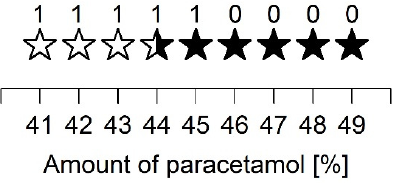
Figure 2. Stability of ASDs prepared with PVP/VA during storage (storage conditions: 23 °C/75% RH and 40 °C/75% RH; no differences were observed between the two storage conditions). Stars represent three types of recrystallization. Open stars show recrystallization in polymorphic form I. Closed stars show recrystallization in polymorphic form II. Semiclosed stars represent recrystallization in both form I and form II. The numbers indicate the weeks in which recrystallization was detected in the XRD measurements.